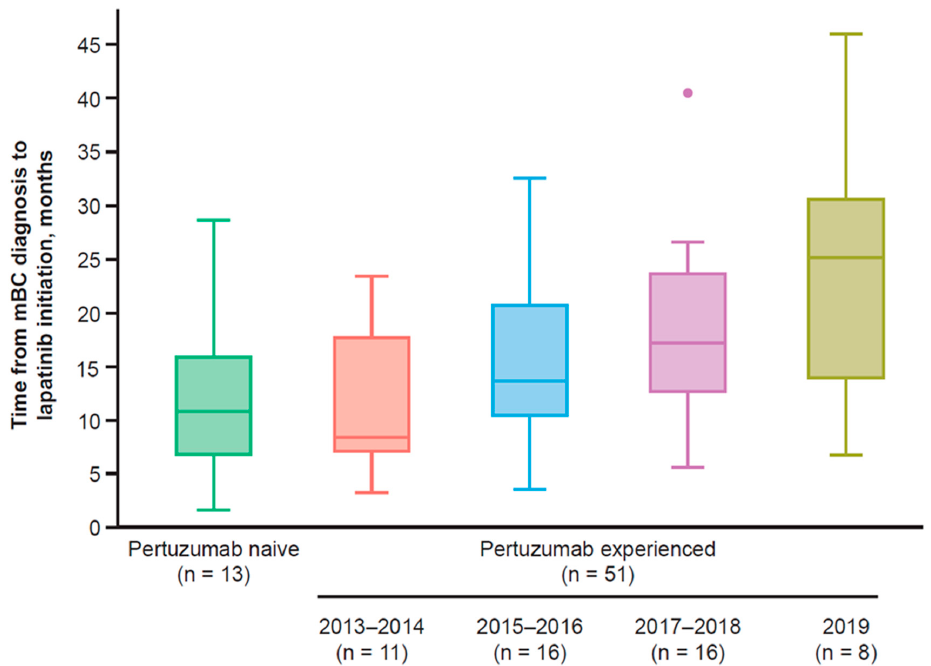
Figure A4. Time from mBC diagnosis to initiation of lapatinib following 1L trastuzumab. The dots denote outliers, which were calculated per Tukey’s method (Q3 + [1.5 × IQR]). From bottom to top, the bars denote the minimum, Q1, median, Q3, and maximum (once outliers have been removed) values, respectively. IQR = interquartile range; mBC = metastatic breast cancer; Q1 = first quartile; Q3 = third quartile; T-DM1 = trastuzumab emtansine.